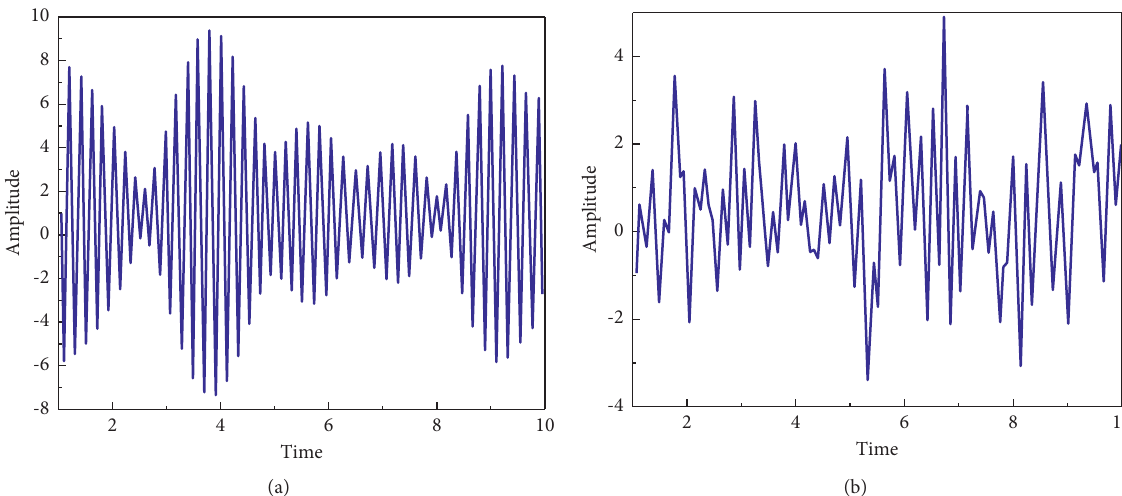
Figure 1: Comparison of wide and narrow band time domain signal waveforms. (a) Narrow band random vibration. (b) Broad band random